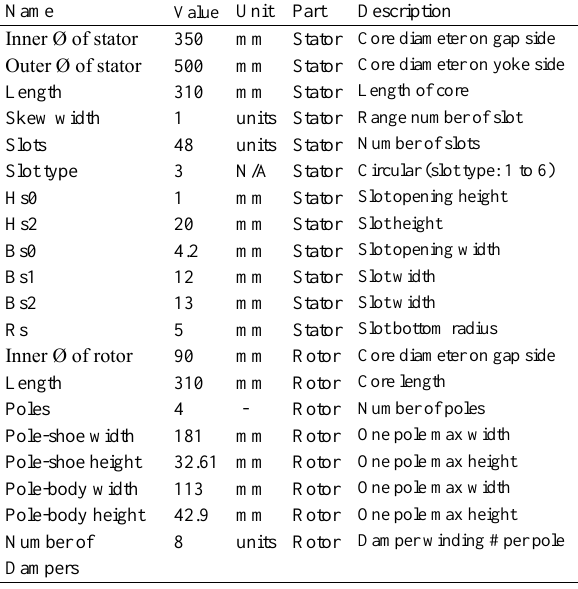
Table 2. General design parameters for 200 kVA SG.